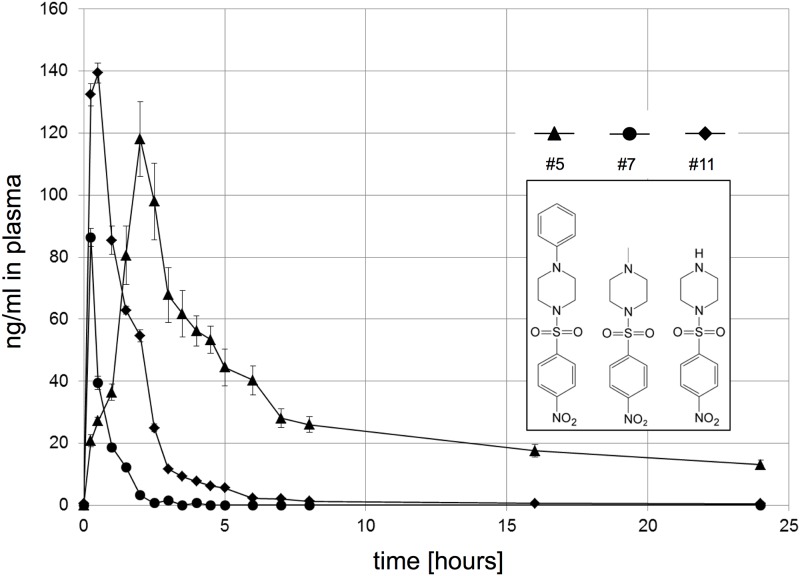
Pharmacokinetics.Pharmacokinetic analysis of compound #5 (triangles) in serum by LC/MS following a single 5 mg/kg s.c. dose showed a drug profile with a Cmax (obs) of 0.12 μg/mL, a Tmax of 2h, a half-life of 9h, AUC (area) 0.41 μg-hr/mL and CL (expo) 0.37ml/hr. Persistence was superior to #7 (circles) and #11 (diamonds) (which was synthesized specially, suggesting the phenyl group improves pharmacokinetic availability. Note: This lack of persistence of #7 might explain its variable performance in vivo as a mitigator.